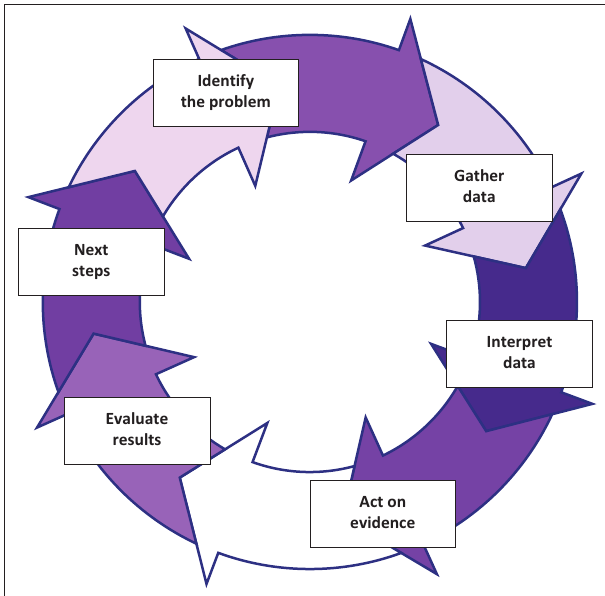
FIGURE 2: Representation of cycles of reflection in action research.